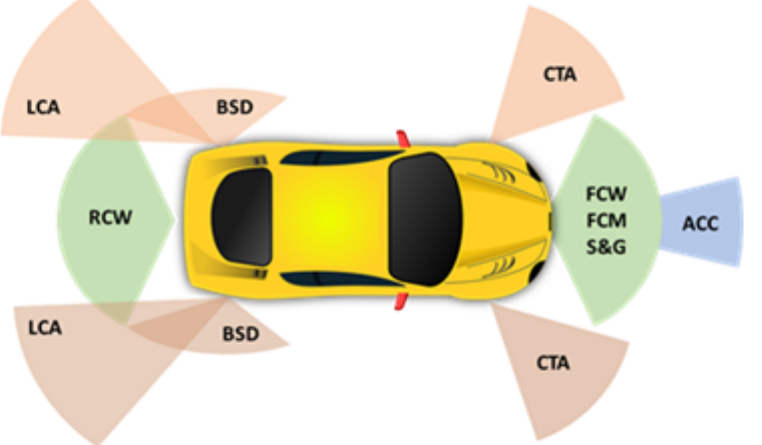
Figure 1. Schema of different radars installed on a vehicle and functionalities. Long range: ACC (Adaptive Cruise Control). Short/Medium range: BSD (Blind Spot Detection), LCA (Lane Change Assist), CTA (Cross Traffic Alert), FCW (Forward Collision Warning), FCM (Forward Collision Mitigation), RCW (Rear Collision Warning), S&G (Stop and